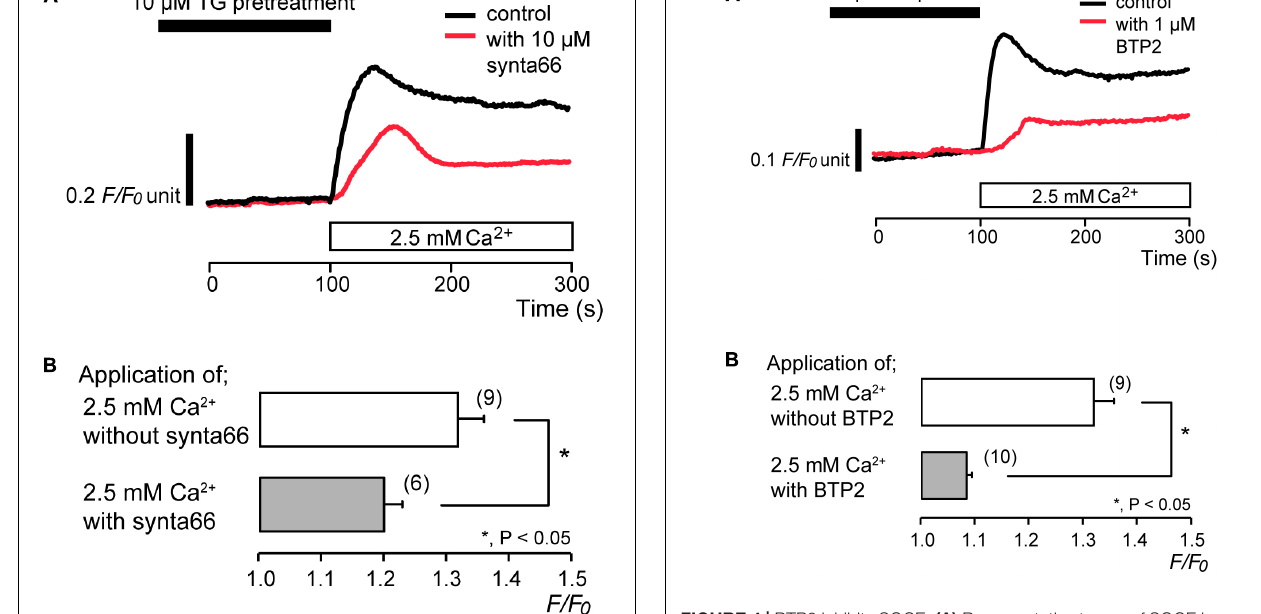
FIGURE 4 | BTP2 inhibits SOCE. (A) Representative traces of SOCE in response to subsequent application of 2.5 mM extracellular Ca 2 + (white box at bottom) after pre-incubation with 10 µ M TG (black box at the top) with (red line), or without (black line) 1 µ M BTP2. (B) Summary bar graph shows [Ca 2 + ] i increase by addition of extracellular Ca 2 + without (open column) or with 1 µ M BTP2 (gray column). Each column indicates the mean ± SE of 9–10 independent experiments. Statistically significant differences between columns (shown by solid lines) are denoted by asterisks, ∗ P <